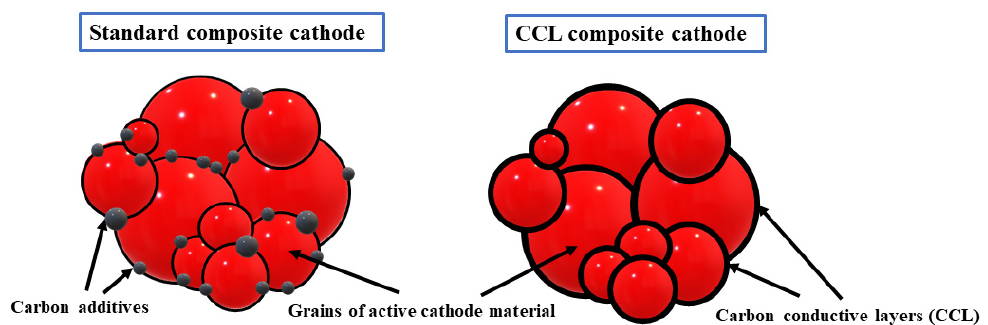
Figure 7. Comparison of standard composite cathode and conductive carbon layers (CCL) nanocomposite cathode in LIBs, based on [84].